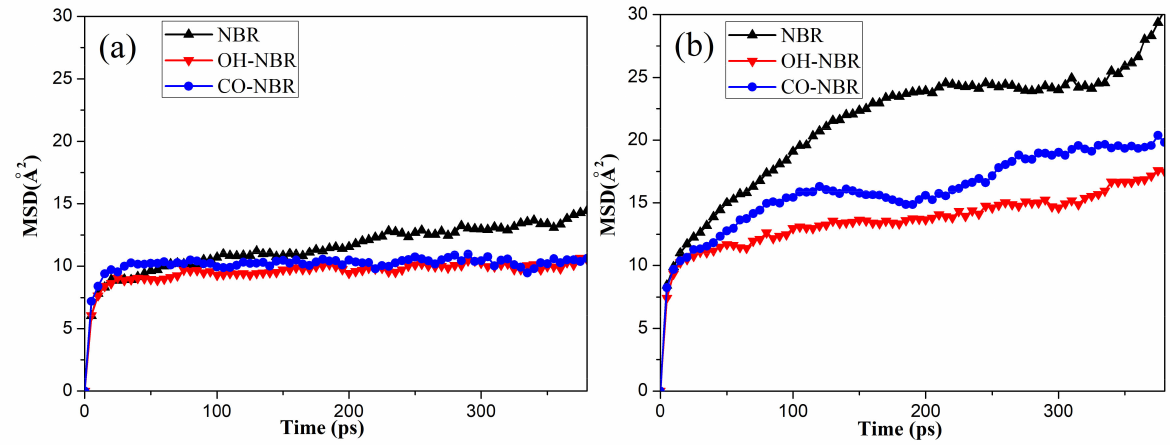
Figure 12. The MSD of the cyclohexane molecules with the simulation time in the unaged and aged NBR models: ( a ) 298.15 K; ( b ) 383.15